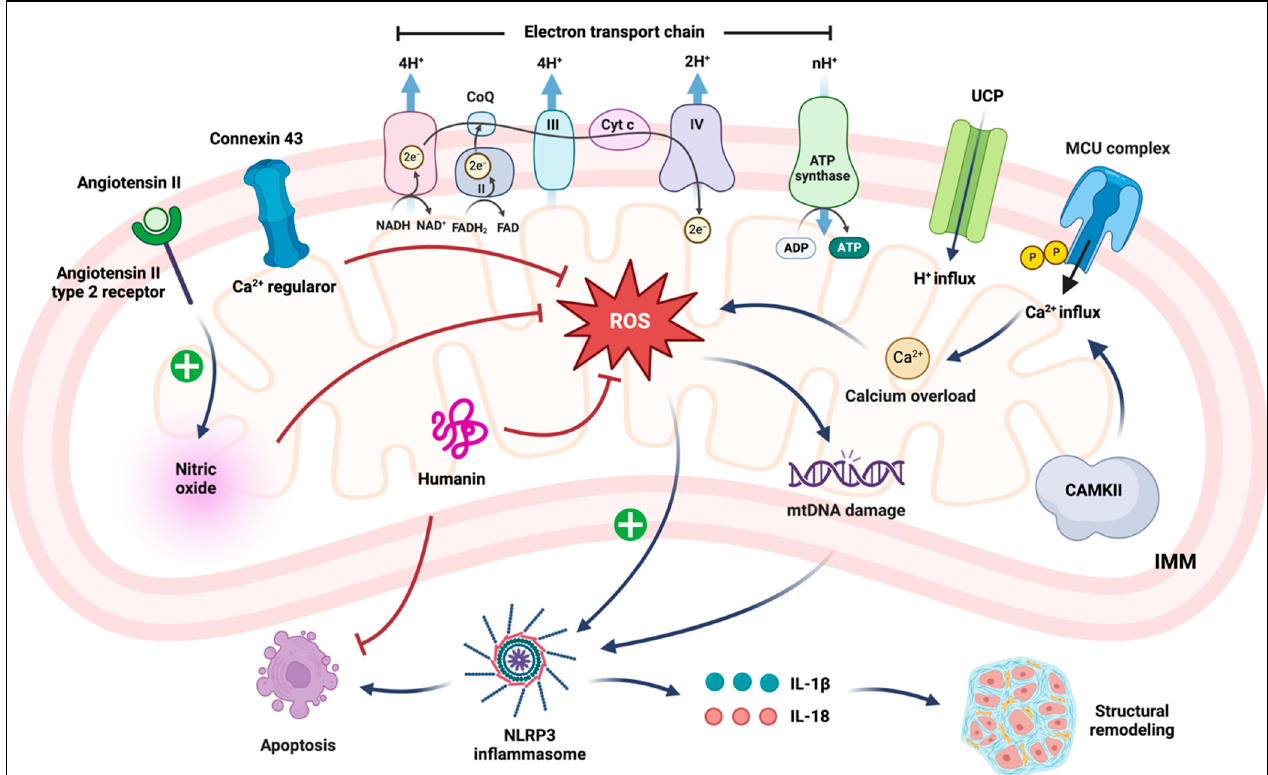
Figure 3. Overview of mitochondrial proteins in cardiac physiology and pathophysiology. A variety of proteins are involved in the functional maintenance of mitochondria. CAMKII activates MCU and allows mitochondrial Ca 2+ overload, which contributes to ROS production. ROS, along with related mitochondrial DNA damage, contribute to the activation of inflammasomes and subsequent cell death. Structural remodeling induced by inflammatory cytokines produced by inflammasomes follows. On the other hand, the increased level of nitric oxide via activation of angiotensin II type 2 receptor, elevation of mitochondrial connexin located on the inner mitochondrial membrane, and augmentation of humanin peptides all contribute to the mitigation of ROS.